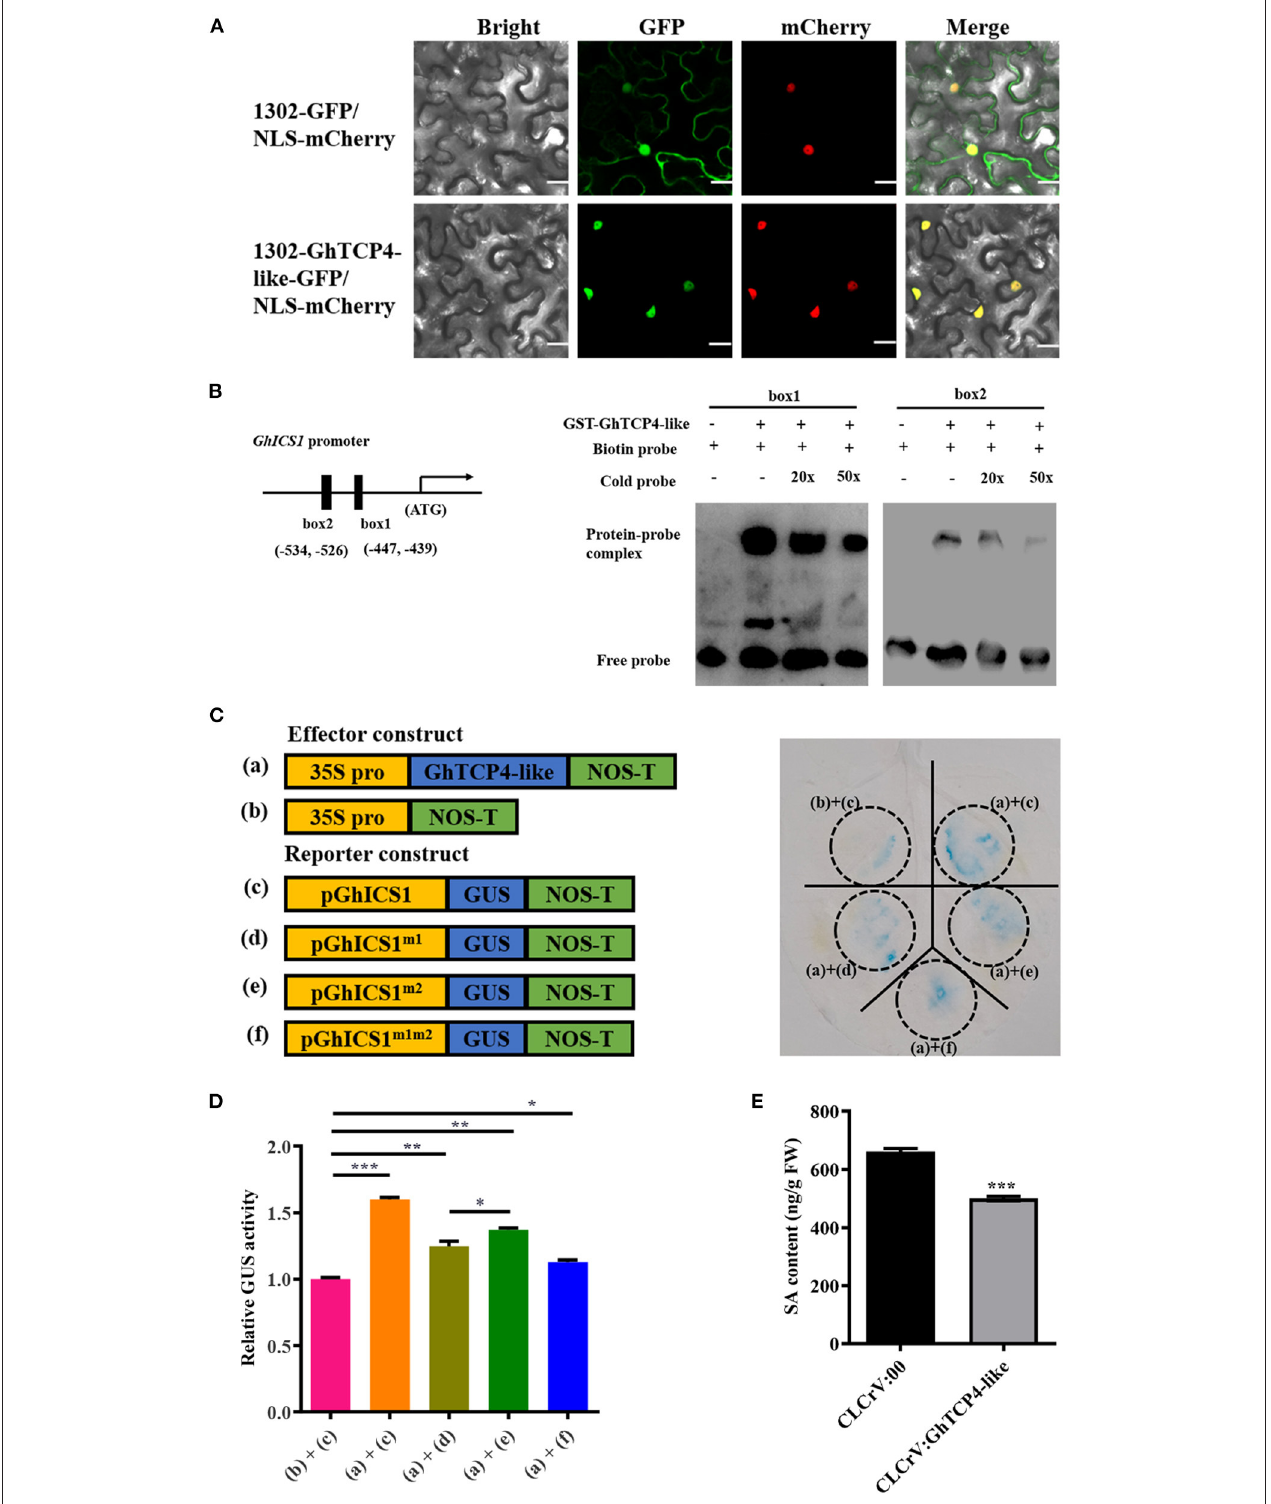
FIGURE 5 | GhTCP4-like directly transactivates GhICS1 expression. (A) Subcellular localization of GhTCP4-like in tobacco leaf cells. NLS-mCherry was a nuclear location marker. Scale bar = 20 µ m. (B) Electrophoretic mobility shift assay (EMSA). Structure of GhICS1 promoter in the left panel. Solid black boxes